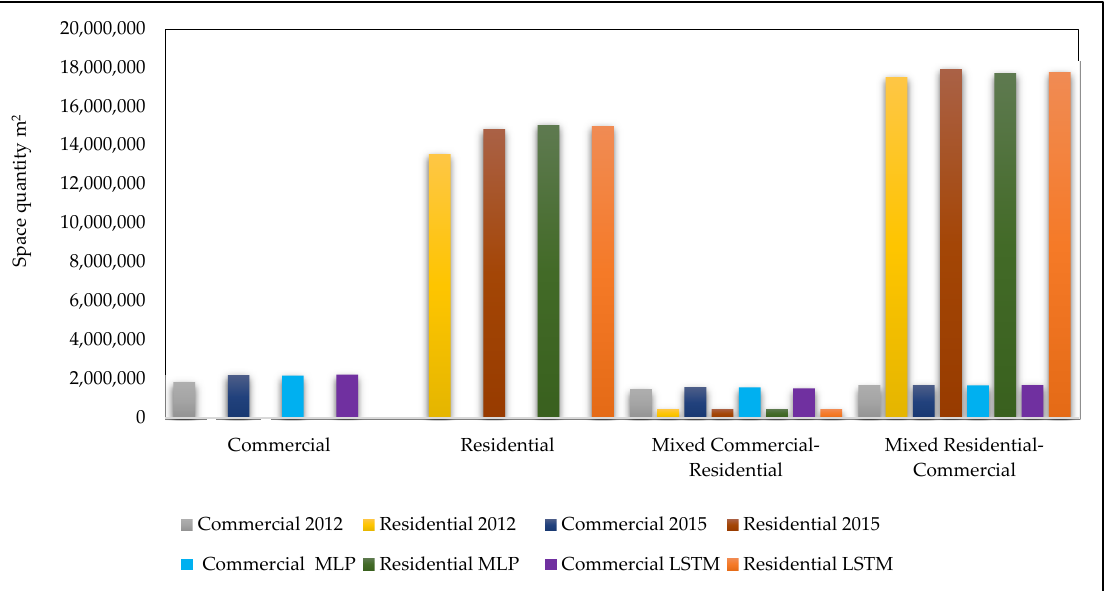
Figure 12. Comparison of the total space quantity change from 2012 to 2015 in Jiang’an district by Parcel type.